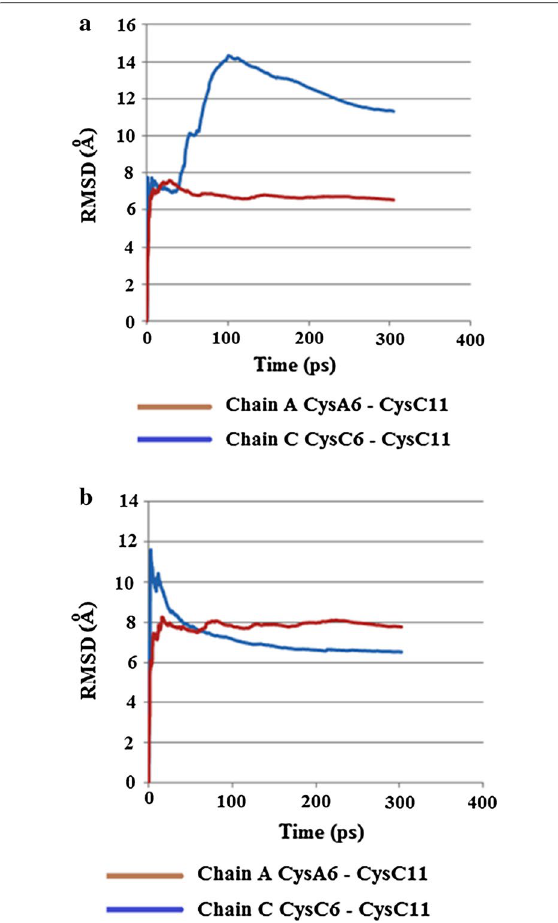
Fig. 23 a Plot of RMSD kinetics of Cys6–Cys11 torsion angles χ3 for the HR insulin, Insugen (I) MD simulations carried out on the minor conformation of chain C Cys6–Cys11 at 310 K. b Plot of RMSD kinetics of Cys6–Cys11 torsion angles χ3 for the HR insulin Insugen (I) MD simulations carried out on the minor conformation of chain C Cys6– Cys11 at 320 K